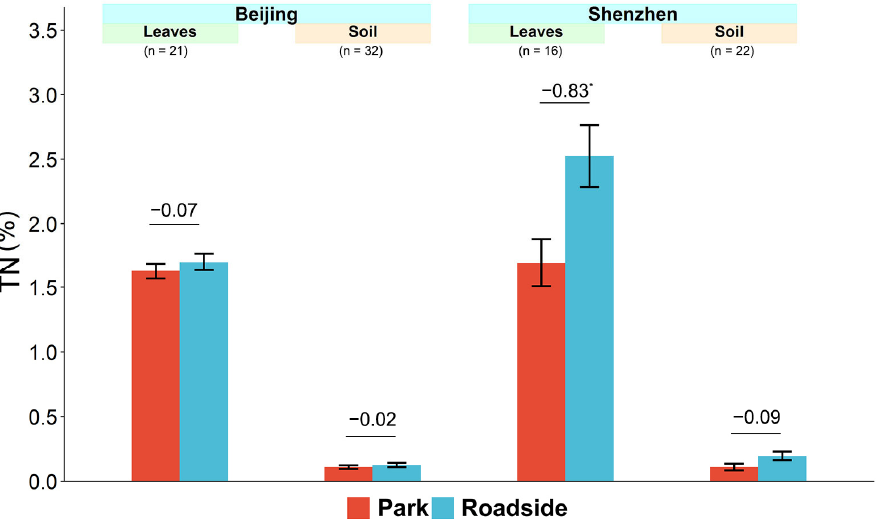
Figure 3. Differences in TN content of urban trees in the green lands (Note: The numbers and asterisk above the bar indicate the mean value differences. Significance of differences: * for p < 0.05. Error bars indicate the upper 95% confidence interval of the